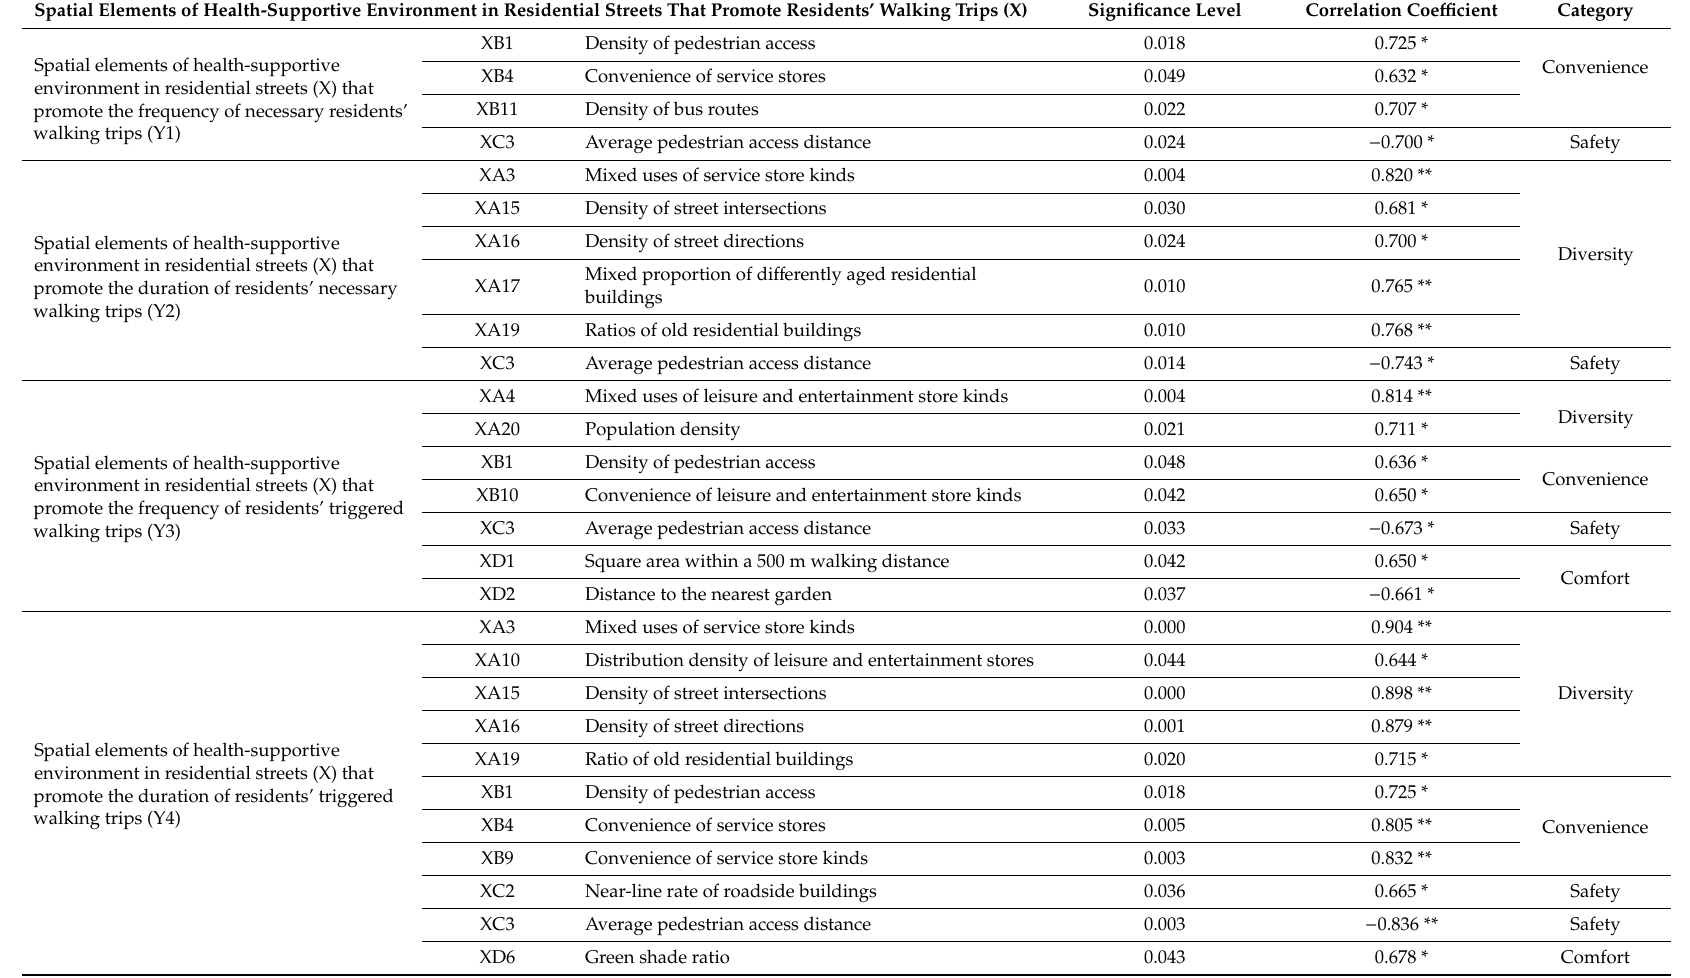
Table 6. Methods of correlation analysis for di ff erent variable types 1